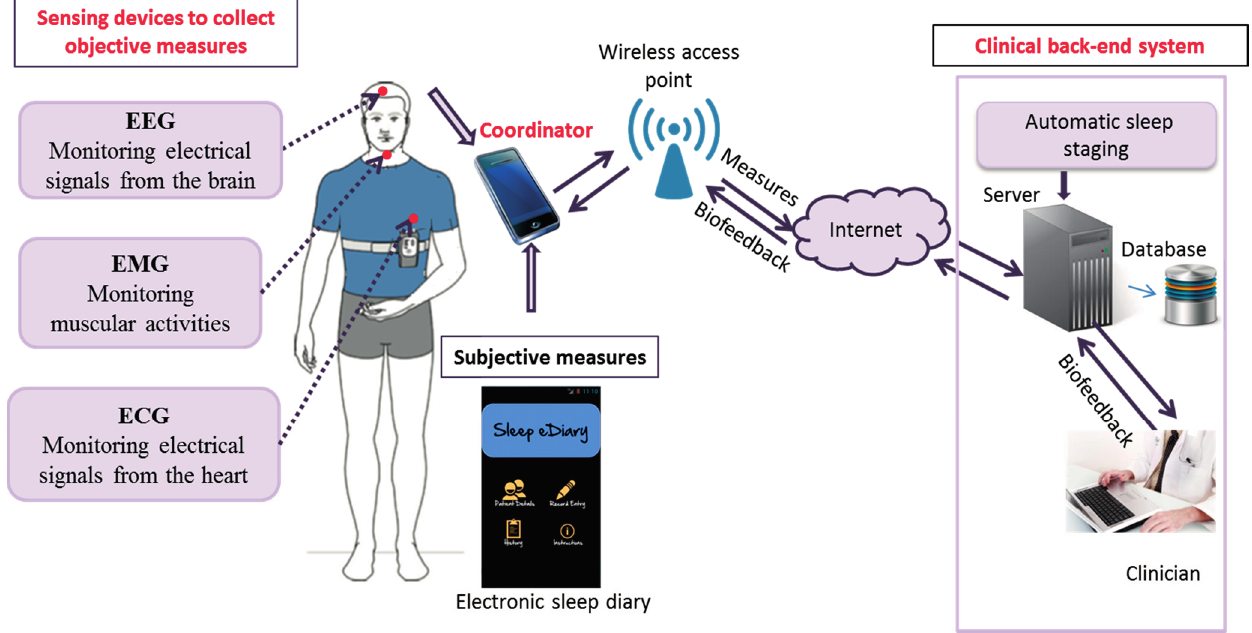
Figure 3. In-home wearable insomnia monitoring and diagnosis